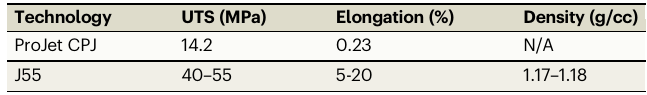
Table 1 | Mechanical properties of ASTM D368 samples printed with ProJet CPJ and J55